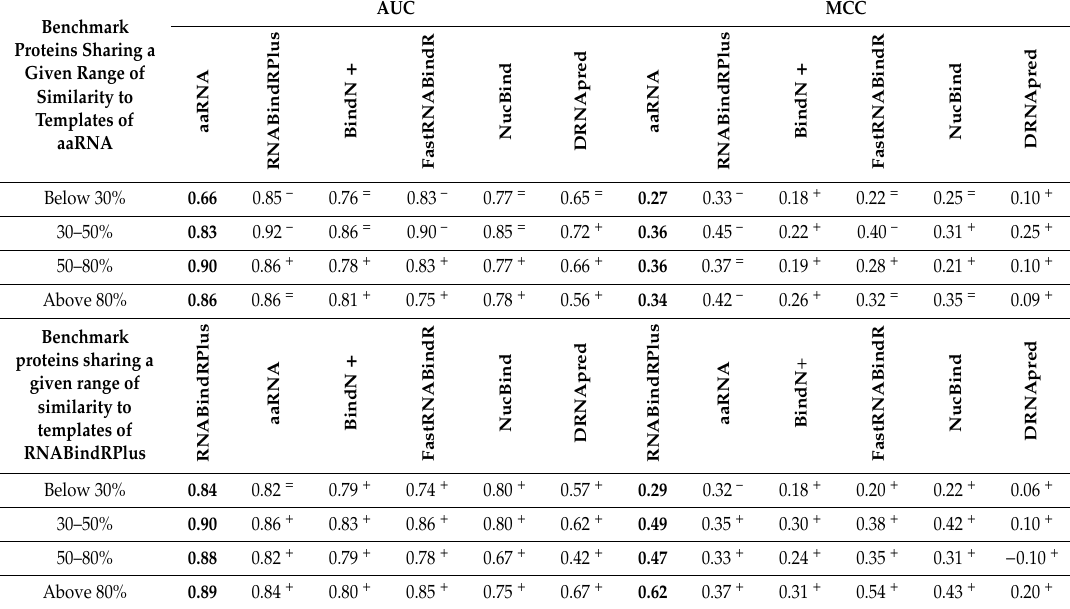
Table 5. Predictive performance of the six partner-agnostic sequence-based predictors of RBRs on the subsets of the benchmark set that share pre-defined levels of similarity to the templates of aaRNA (top of the table) and RNABindRPlus (bottom of the